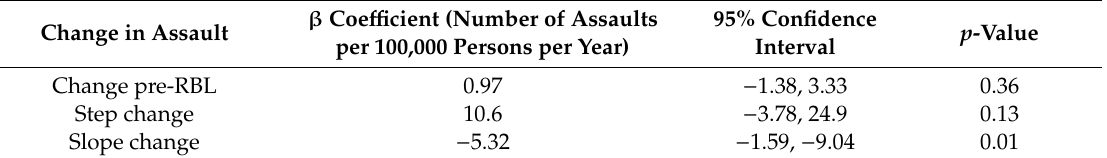
Table 1. Change in the incidence of assault during “high alcohol hours” from pre- to post-RBL implementation in Queensland.